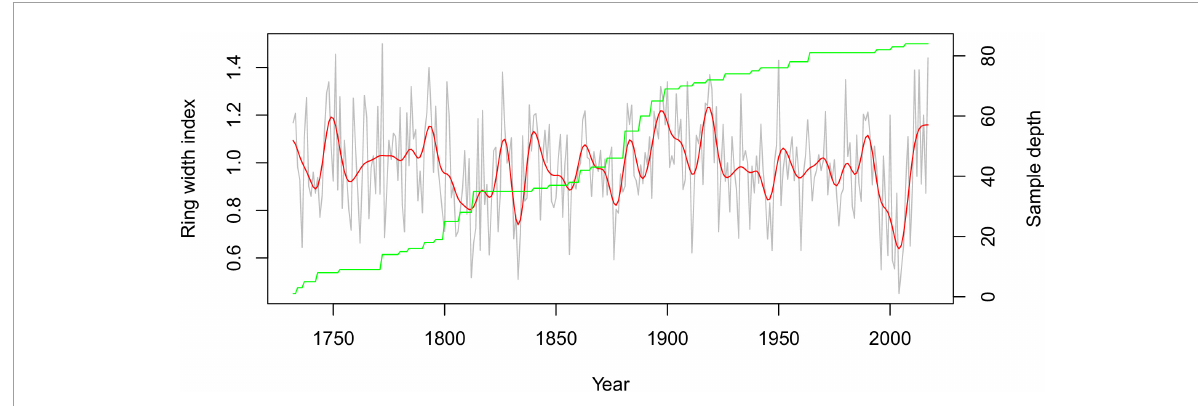
FIGURE3 Ring-width index (RWI) chronology of Rhododendron arboreum from Darma valley; green line indicates sample depth, and red line plot indicates 10-year low-pass filter.